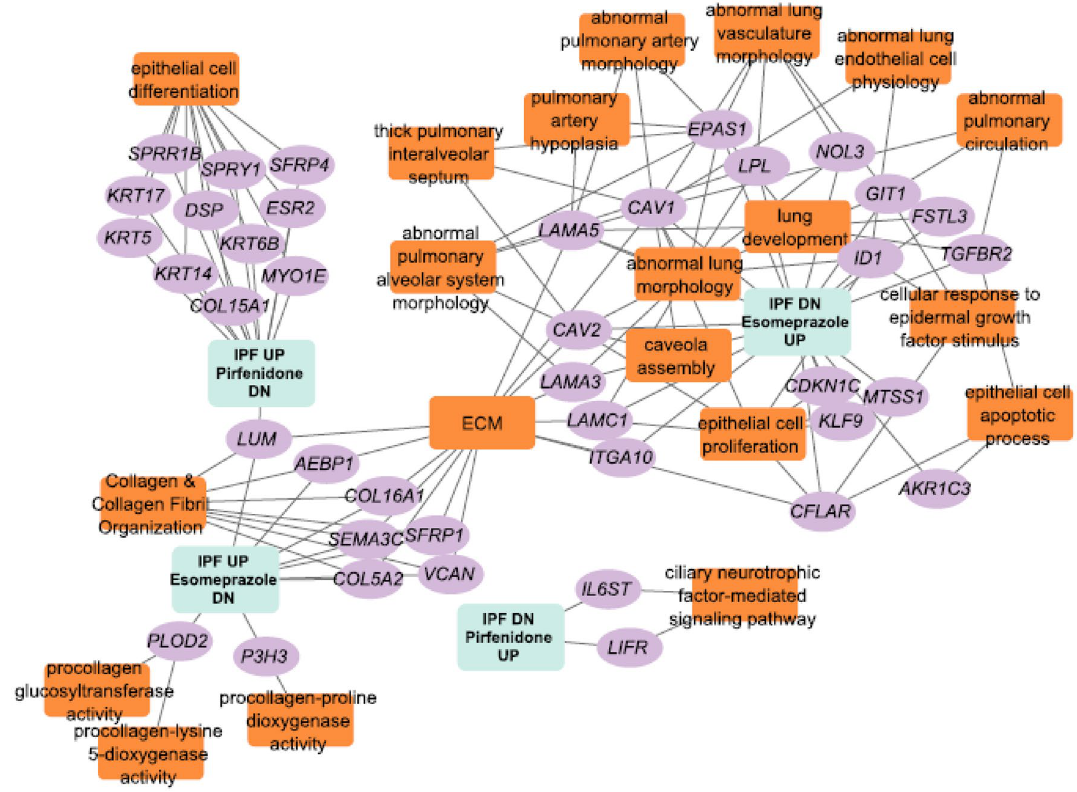
Figure 5. Network representation of genes and biological processes and pathways that are dysregulated in IPF and are controlled by esomeprazole, pirfenidone, or the combination. Orange-colored rectangles represent enriched biological processes, pathways or phenotypes while the purple-colored oval shapes represent genes that are up or down regulated by esomeprazole, pirfenidone or the combination but reciprocally regulated in IPF. The gene expression data for esomeprazole and pirfenidone treatment is from the Library of Integrated Network-based Cellular Signatures (LINCS) database while the IPF dysregulated gene expression data is from human patients. Functional enrichment analysis is done using ToppFun application and network generation is done using Cytoscape